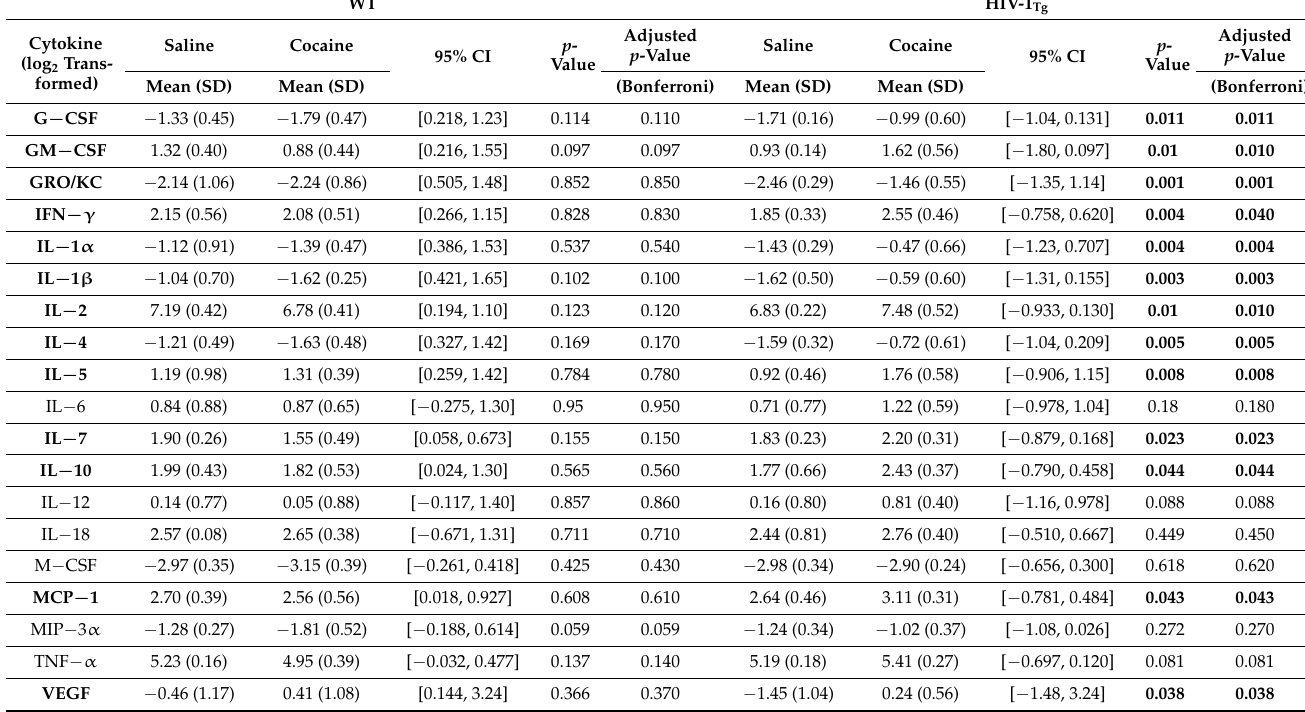
Table 1. Frontal cortex (fCTX) cytokine level summary statistics stratified by rat model WT vs. HIV-1 Tg . Student’s t -tests with unequal variance were used to compare the difference in mean expression levels (and SD) of each cytokine, chemokine, or growth factor in WT (saline-yoked ( n = 7) and cocaine SA ( n = 8)) and HIV-1 Tg (saline-yoked ( n = 6) and cocaine SA ( n = 6)) in the fCTX. The 95% CI, overall p value and cumulative replicates are given in the table. Bold cytokines, chemokines, or growth factors indicate targets that were significantly increased in HIV-1 Tg rats compared to WT.